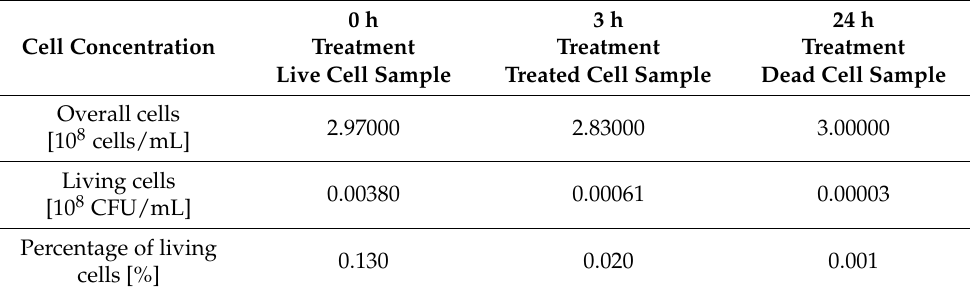
Table 1. Concentration of L. sphaericus JG-A12 cells after adding 0.02 mg/mL the antibiotics tetra- cycline and 0.1 mg/mL chloramphenicol and after incubation for 3 h and 24 h, 30 ◦ C, 120 rpm in the dark. 0 h 3 Cell Concentration Treatment Live Cell Sample